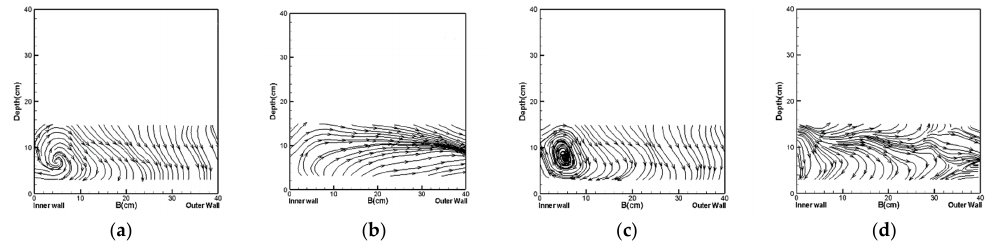
Figure 9. The latitudinal distribution of velocity at 70 degrees with and without a W − Weir, ( a ) Fr = 0.17 with a W − Weir, ( b ) Fr = 0.17 without a W − Weir, ( c ) Fr = 0.28 with a W − Weir, and ( d ) Fr = 0.28 without a W − Weir.